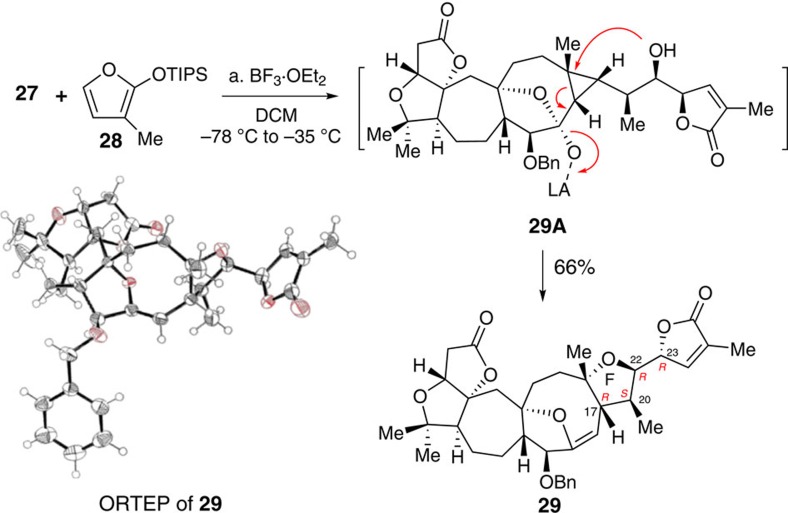
Total synthesis of 29.(a) 28 (3.0 eq), BF3·OEt2 (3.3 eq), DCM, −78 to −35 °C, 66%.